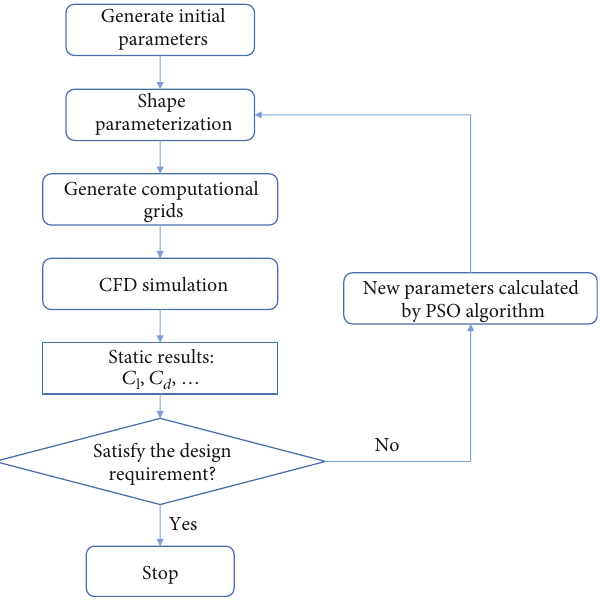
Figure 1: Traditional pneumatic optimization design